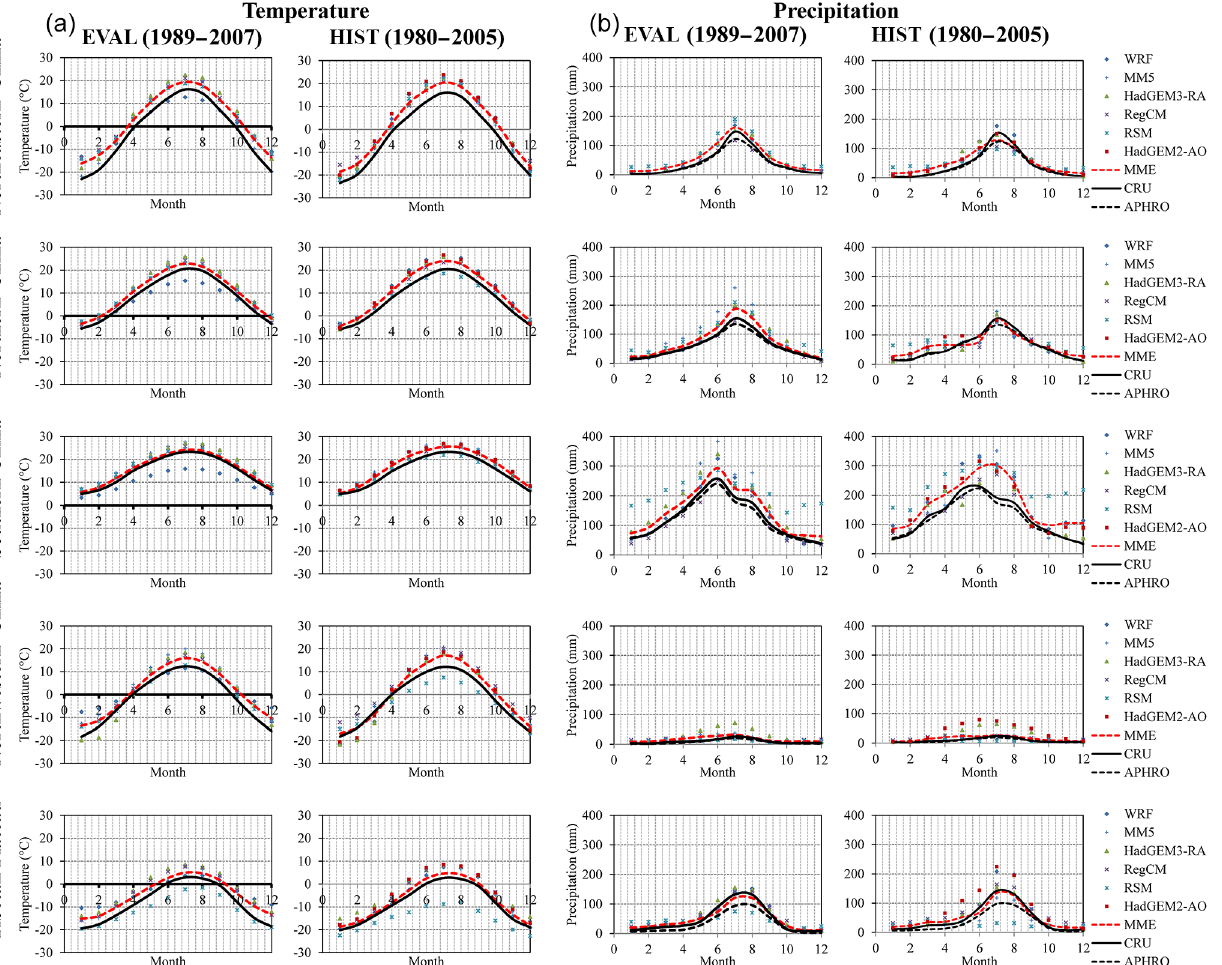
Figure 6. Observed and simulated monthly mean temperature (a) and precipitation (b) over the five subregions during the 1989–2008 (EVAL) and 1980–2005 (HIST)